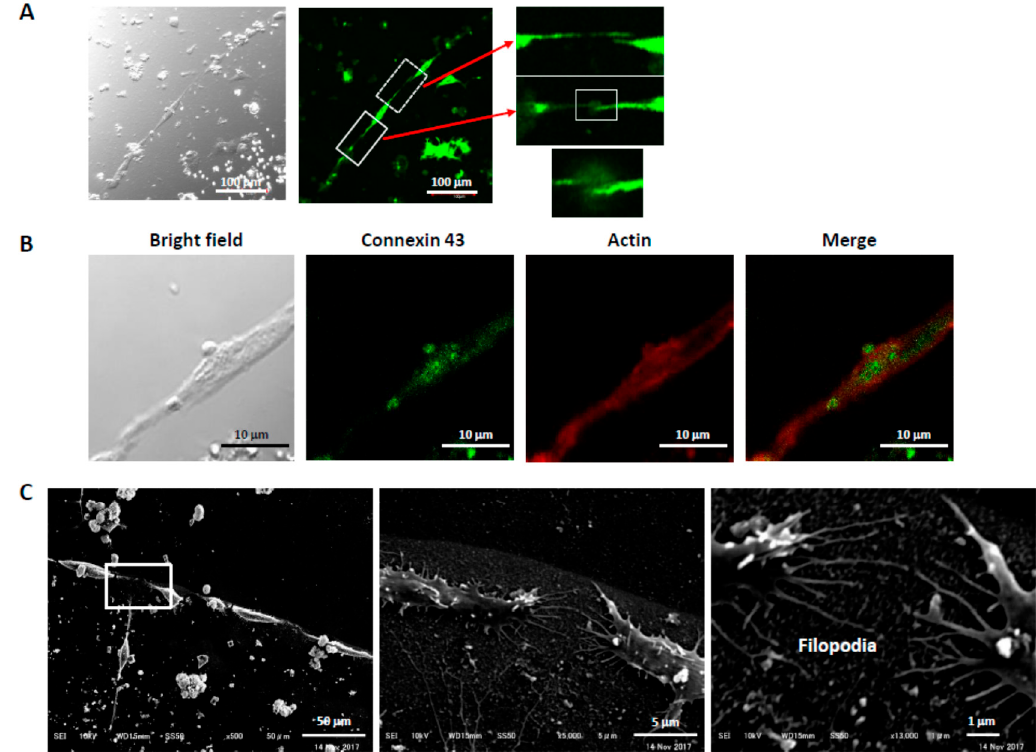
Figure 5. Connections between the aligned PC12 cells. ( A ) Connection via the extended axon. The extended axon induced by H1-tagged pfNGF was detected by expression of neurofilament. Connections between the extended axon and the growth cone-like structure (solid box) and between the axons (dotted box) were observed. ( B ) Expression of connexin 43. A gap junction protein, connexin 43, was detected in connecting sections of the extended axons. ( C ) Connection by filopodia. Very fine filopodia were extended and connected between growth cones.